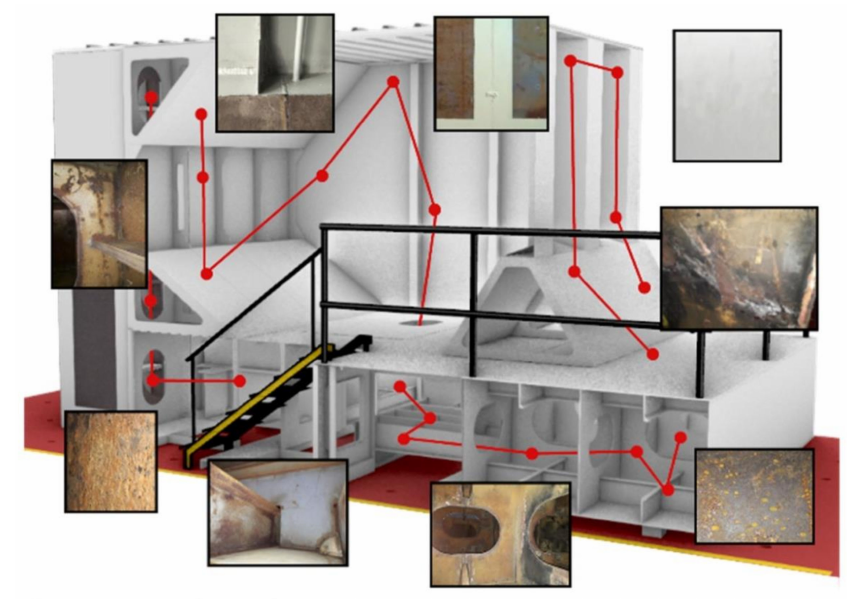
Figure 28. The construction module of a testing facility